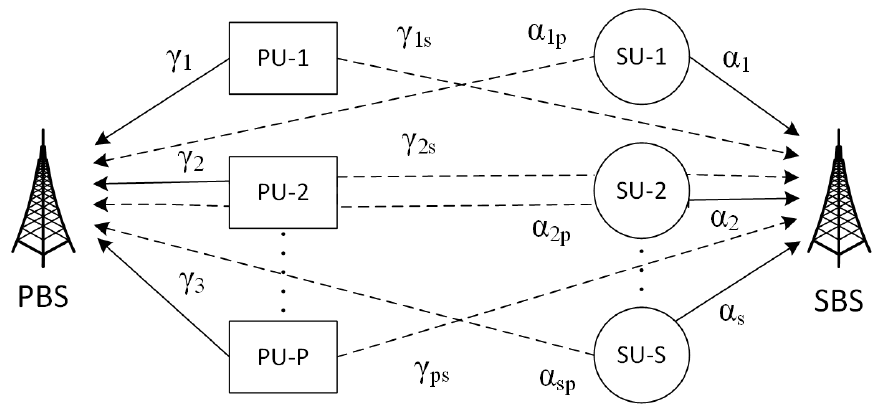
Figure 2. A cognitive radio network (CRN) with a primary base station (PBS) and primary users ( P -PUs), and secondary base station (SBS) with secondary users ( S